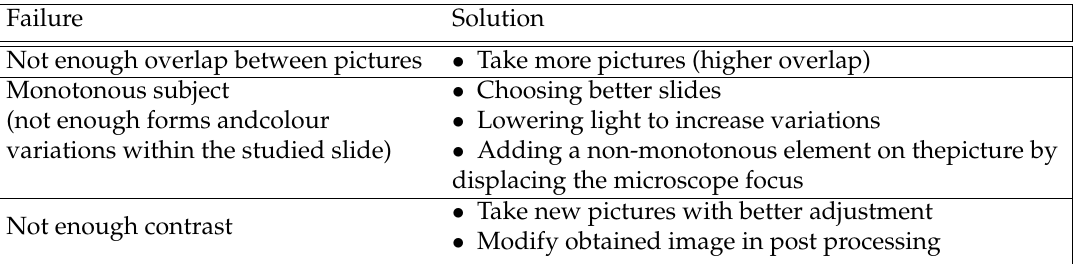
Table 2. Probable causes of failure and proposed